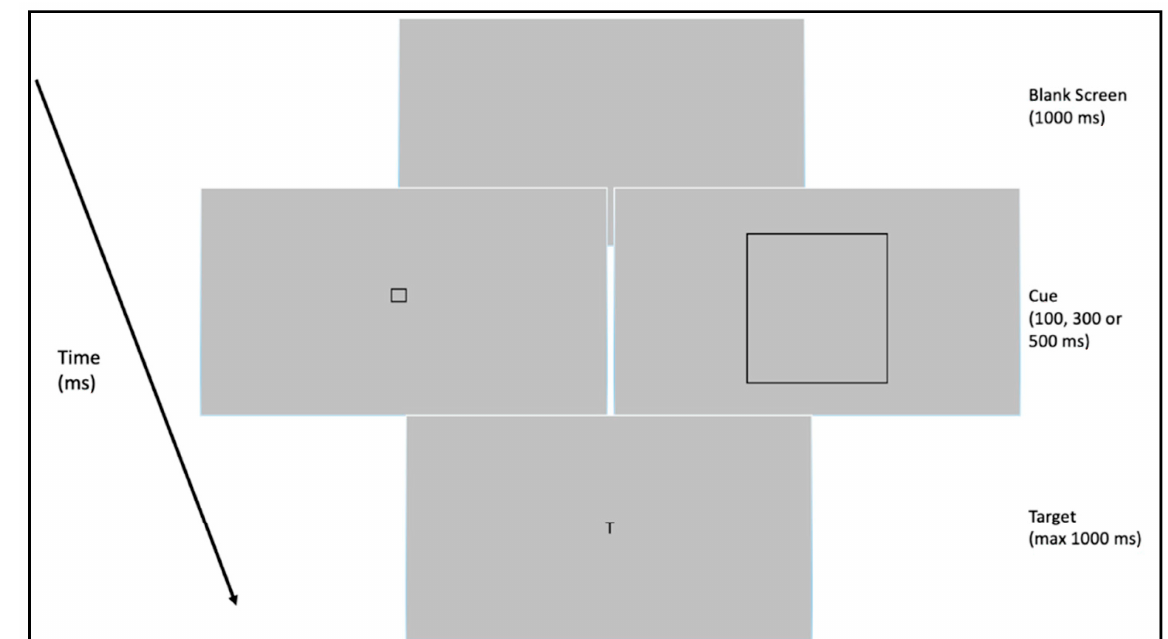
Figure 5. Example of the trial procedure in Experiment 3. After a blank screen (1000 ms), the target appearance could be preceded by no cue, a red dot, a small cue, or a big cue (in the interests of readability, in the figure, only the last two conditions are shown). After 100, 300, or 500 ms, the target (T) was presented, and the participant was asked to respond as quickly as possible by pressing the space bar on a keyboard.